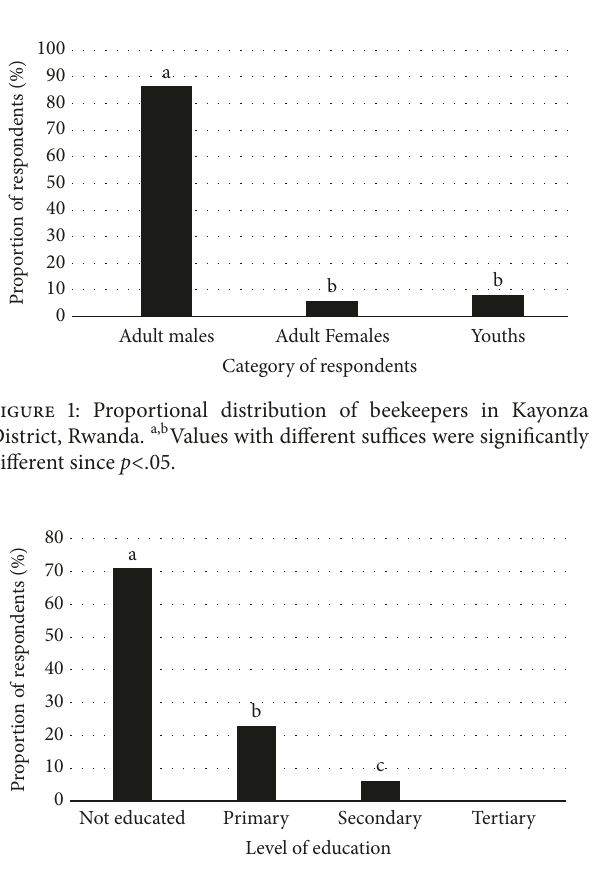
Figure 2: Proportional level of education of beekeepers in Kayonza. a , b , c Values with different suffices were significantly different since p <